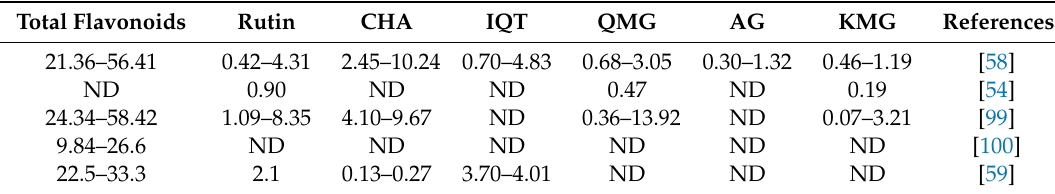
Table 2. Flavonoid and phenolic contents (mg/g) in mulberry leaf biomass. Total Flavonoids Rutin